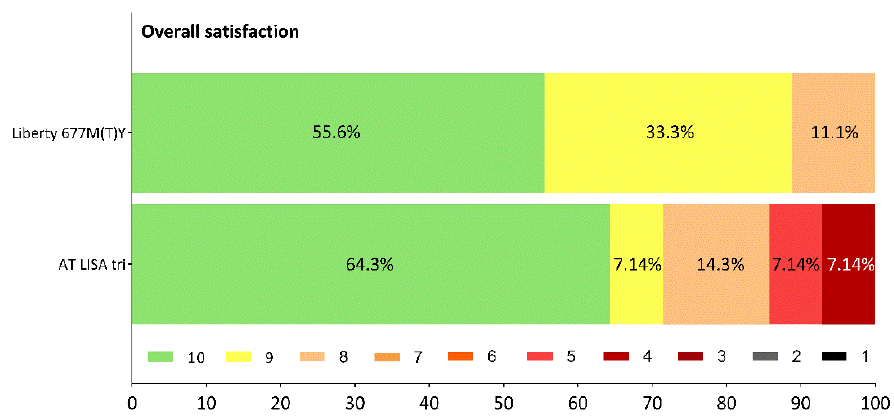
Figure 7. Overall satisfaction reported by patients at 12 months after surgery. 10 = highest ranking; 1 = lowest ranking.